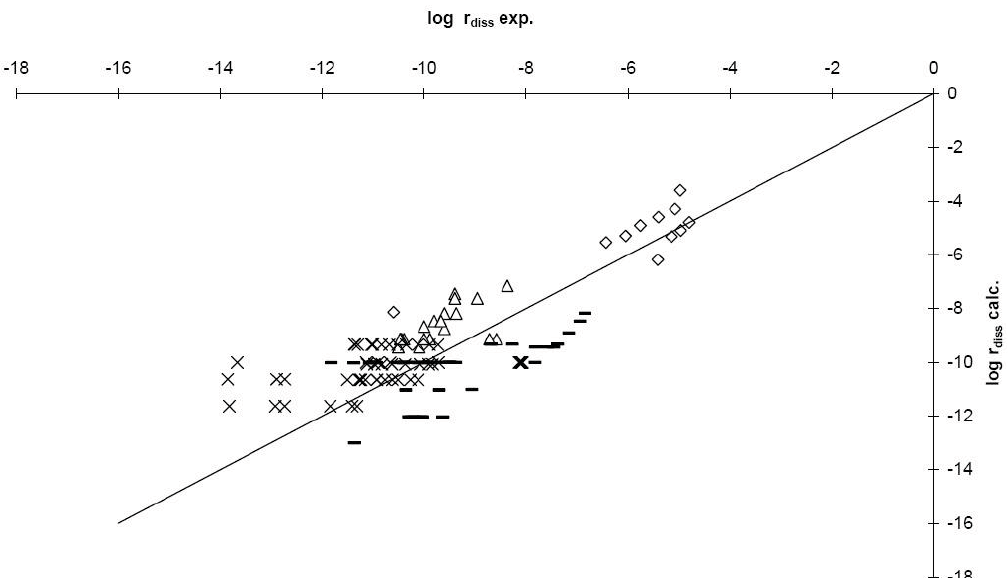
Figure 1. The logarithm of calculated dissolution rates plotted versus the logarithm of experimentally determined dissolution rates [8-18] for differ- ent systems; ◊ H O , with carbonate, ∆ H 2 2